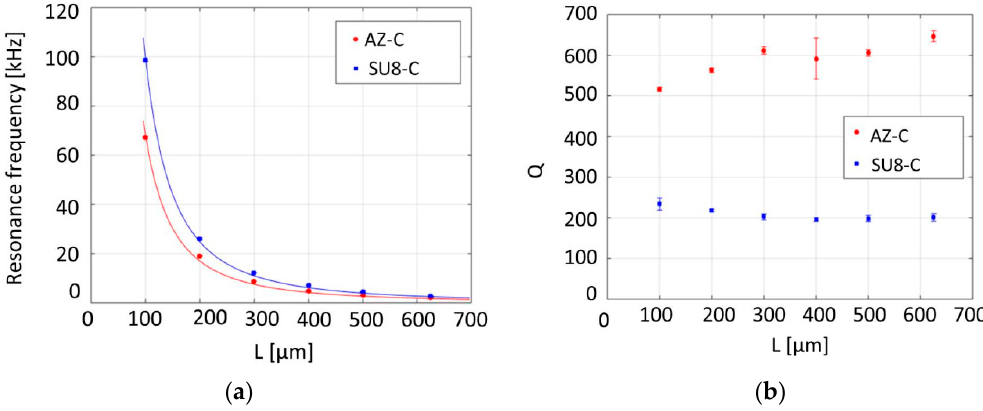
Figure 4. Relation between length and ( a ) resonance frequency of the fundamental bending mode and ( b ) Q of the carbon cantilevers fabricated with the “ pyrolysis-dry etch ” scheme using SU-8 and AZ photoresist precursors. Error bars represent a 95% confidence interval. Measurements were done on five cantilevers and then averaged.